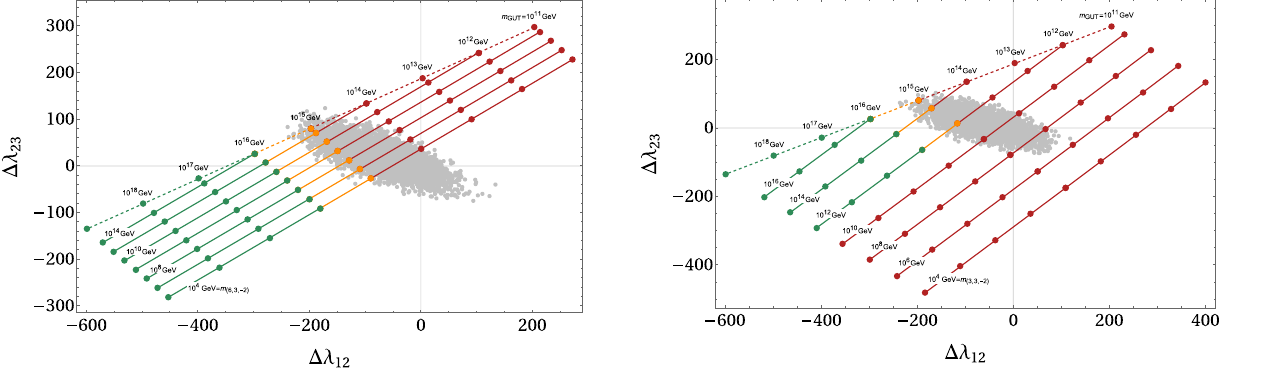
Fig. 6 Prospects for gauge unification in scenarios with light ( 1 , 3 , 0 ) scalars. No sufficiently high unification scale can be realized, even if we take threshold corrections with R ∈ [ 1 account,